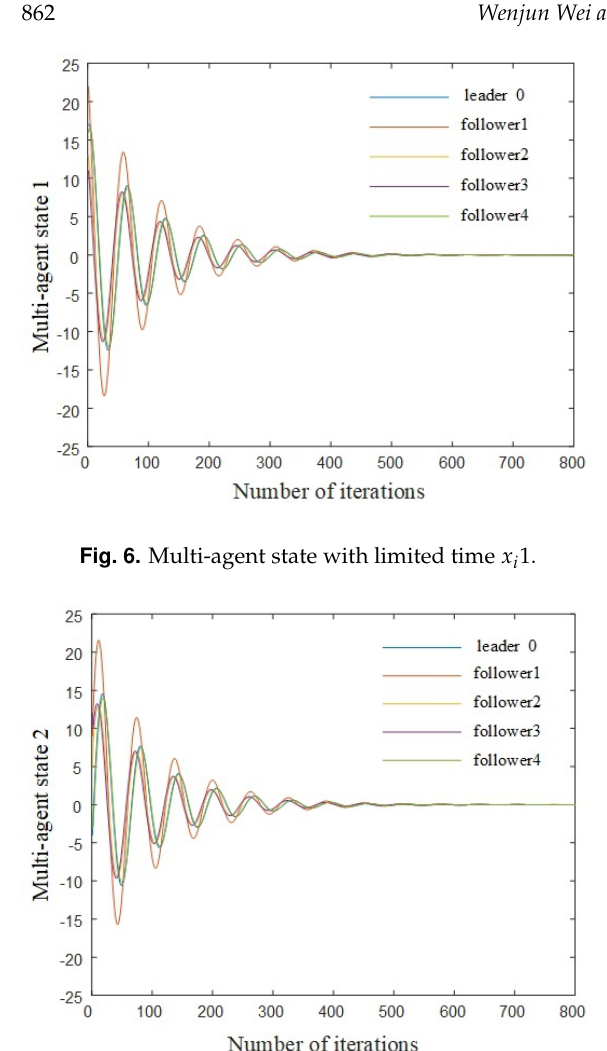
Fig. 7. Multi-agent state with limited time x i 2. gent Control (Lanzhou Jiaotong University)- (KFKT2020-